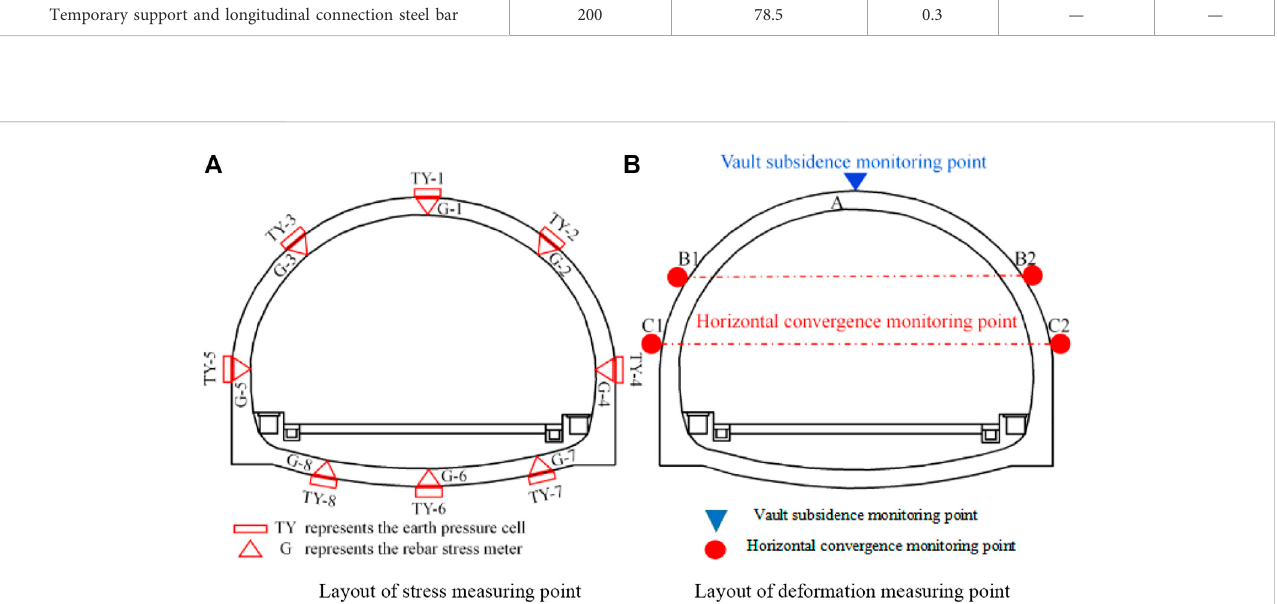
Figure 7B showed that the stress concentrated at the left and right arches after upper bench excavation, and the maximum stress was 2.83 MPa. After the middle bench is excavated, the stress was mainly distributed in the arch waist, arch foot and side wall. And the stress was roughly symmetrical on both sides, with the maximum stress appeared in the left wall, about 3.16 MPa, as shown in Figure 7C. After the excavation of lower bench and the addition of secondary lining, the stress of the structure was still mostly concentrated in the arch waist, arch foot and side wall, with the stress release ratios were about 80% 10% and 10%, and the maximum stress was 3.55 MPa, as shown in Figure 7D. It can be seen from Figure 8 that during soil excavation at the left upper bench, the stress gradually concentrated at the left arch foot, with a maximum of 2.75 MPa. After the excavation of the left lower bench, the large stress was mainly concentrated in the arch waist, arch foot and side wall on the left side. In addition, a large stress appeared at the temporary support arch foot for the right upper bench, with the value of 2.86 MPa. With the removal of the temporary support and the construction of secondary lining, the response range of surrounding rock stress dwindled and eventually stabilize. This indicated that the stress was basically released and the maximum stress was 3.12 MPa, as